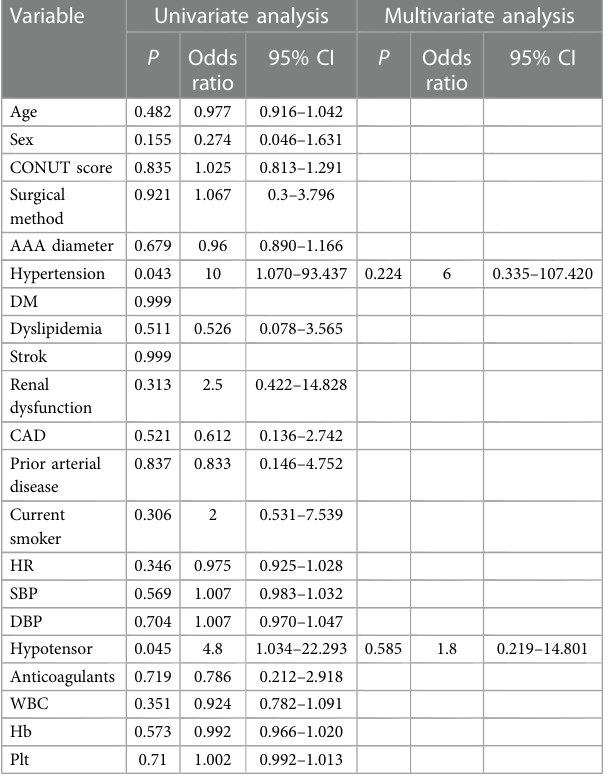
TABLE 4 Logistic regression analysis of postoperative complications and reoperation. Variable